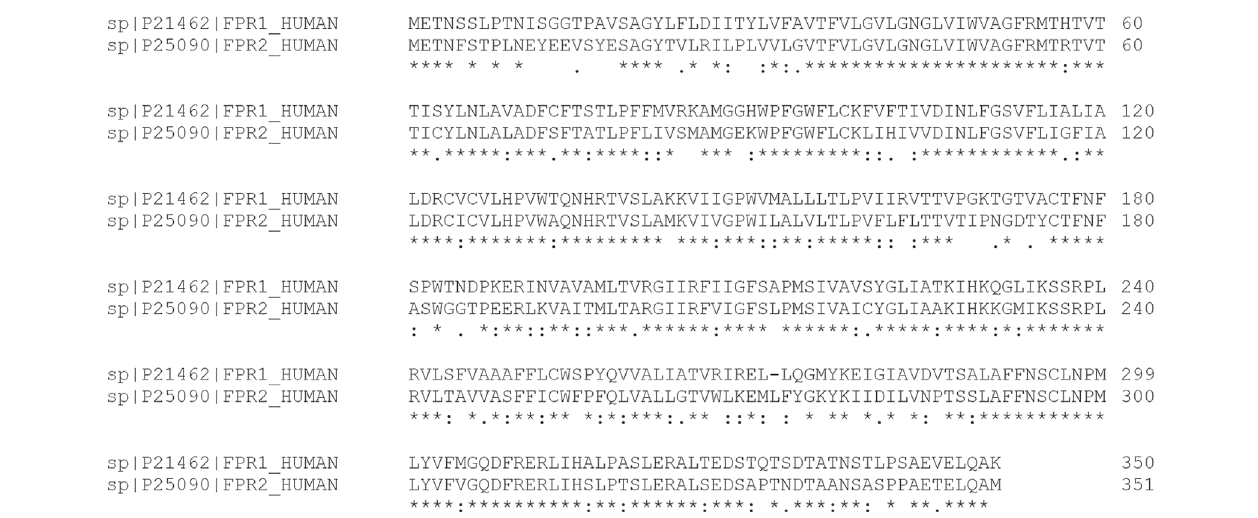
FIGURE6| ComparativesequencealignmentofFPR1andFPR2.MultiplesequenceanalysisdemonstratesthathumanFRP1andFPR2sharesigni fi cantdegreeof amino acid sequence identity.